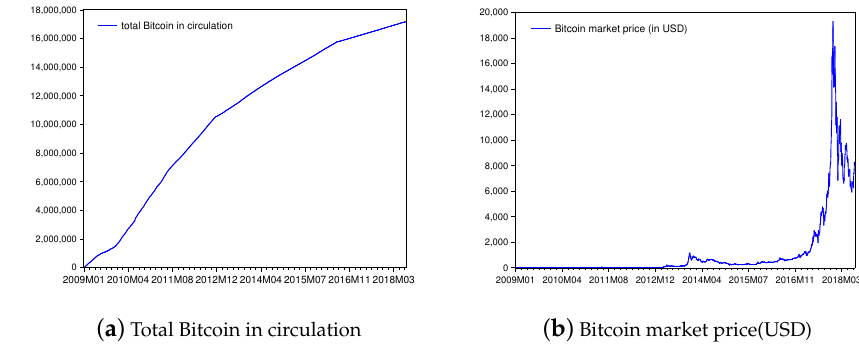
Figure 1. Total Bitcoins in circulation and its market price since